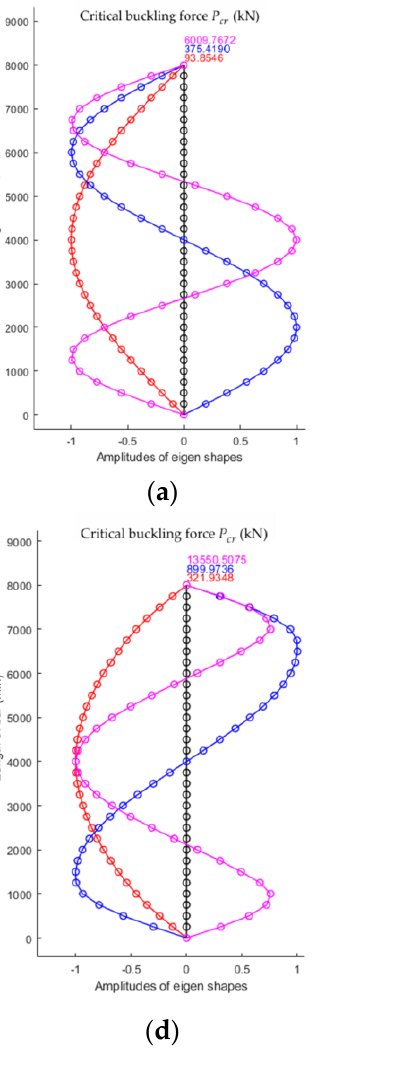
Table 3. Comparison between the critical buckling force 𝑃 𝑐𝑟 obtained by the FEM with the one obtained with the analytical model for different cases of bars involved in this research.